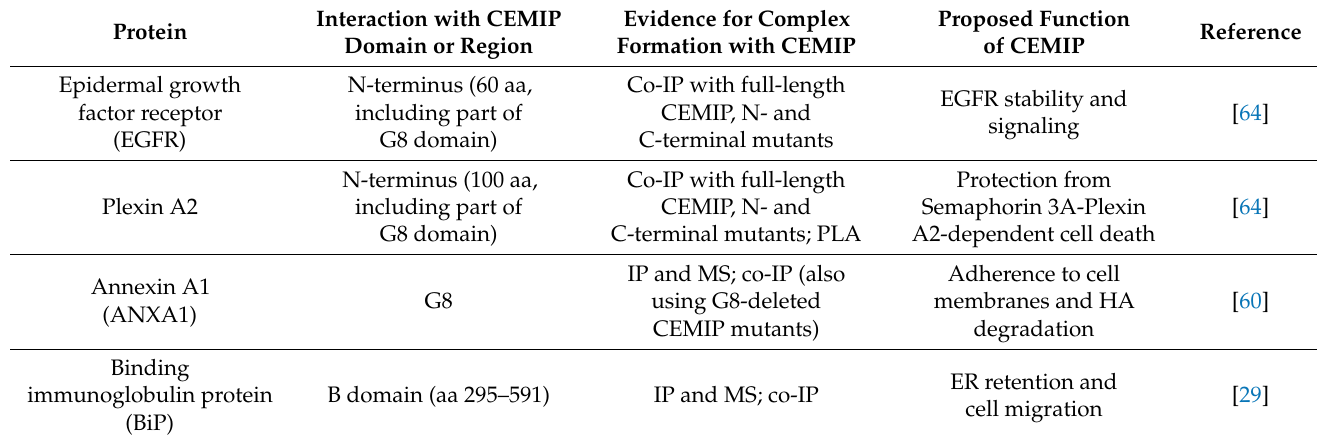
Table 1. Summary of the molecular interactions of